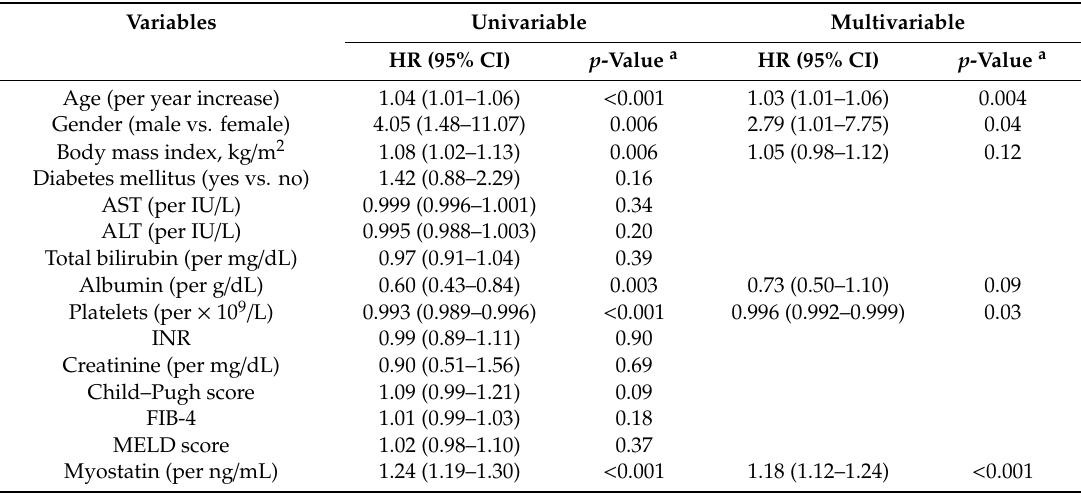
Diabetes mellitus (yes vs. no) 1.42 (0.88–2.29) 0.999